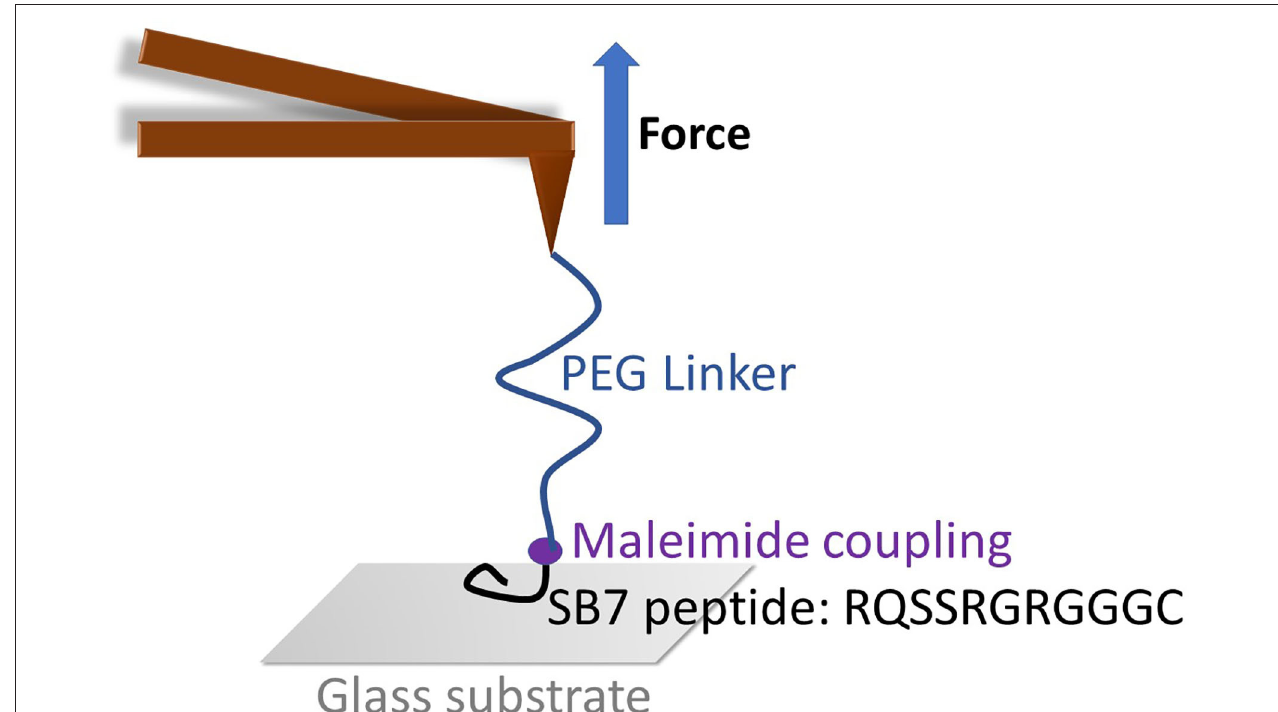
FIGURE 1 | The schematic of SMFS experiment on SB7. The maleimide functionalized AFM tip was coupled with SB7 peptide through maleimide-thiol chemistry using a 35 kDa PEG linker.